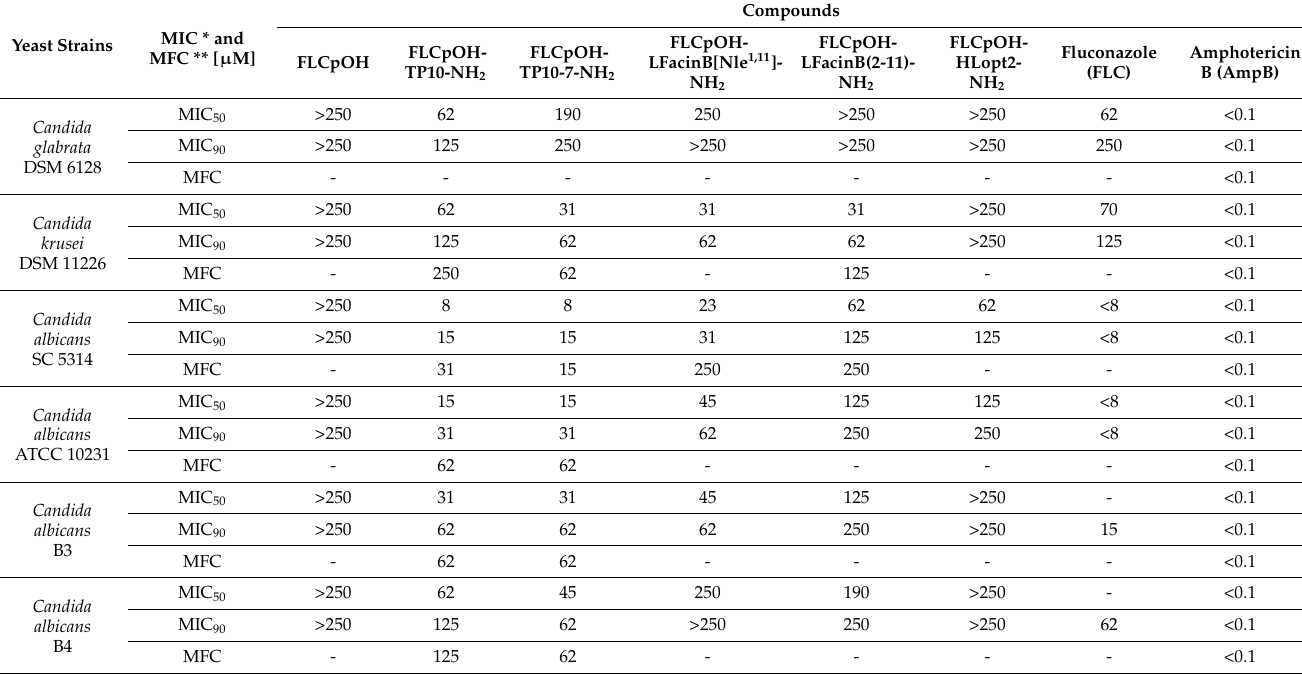
Table 2. MIC and MFC Values (in µ M) Determined for Compounds, As Well As for Two Control Antifungal Agents (AmB and FLC) against Various Yeast